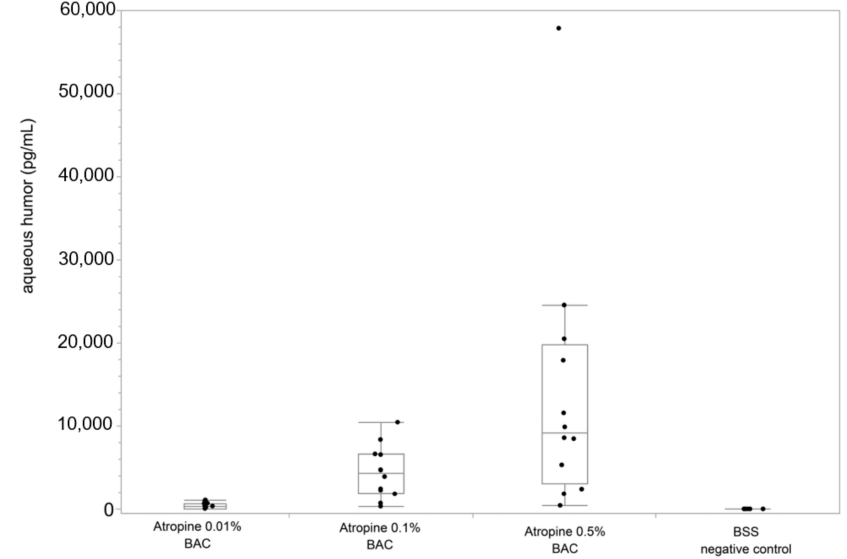
Figure 2. Concentration of atropine sulphate in aqueous humor for different atropine concentrations (0.01%, 0.1%, 0.5%, all including BAC). The bars within the box plots represent the medians, the edges represent the 25th/75th percentiles, and the whiskers extend from the ends of the box to the outermost data points within the quartile—1.5 × of the interquartile